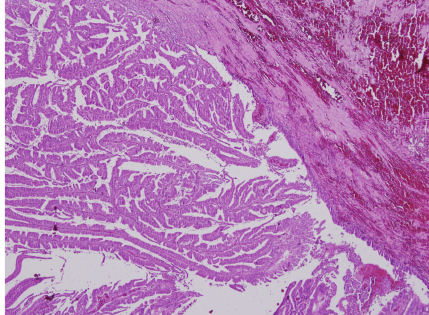
Figure 3: Atypical epithelial cells lining a fibrovascular core extend- ing from the cyst wall that is lined by columnar epithelium are seen on the histopathological